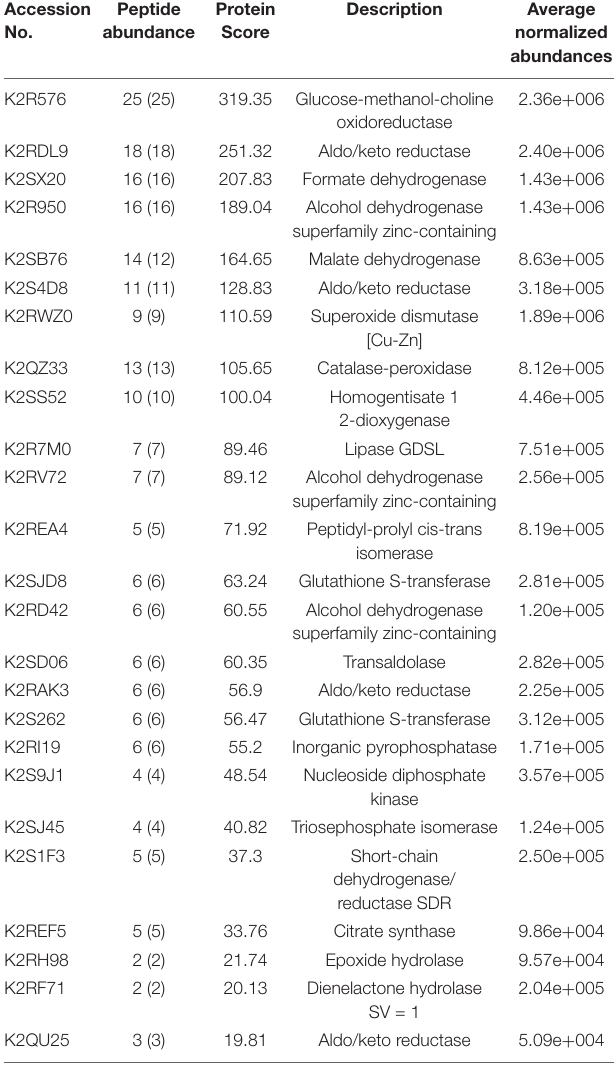
TABLE 3 | List of enzymes with signal sequence as identified by Signal P found in TABLE 2 | List of enzymes without having known signal sequence as identified by the LC–ESI-MS-MS data of M. phaseolina secretome. Signal P found in the LC-ESI-MS-MS of M. phaseolina secretome. Accession Peptide Protein Description Average Accession Peptide Protein Description Average No. abundance score No. abundance Score normalized